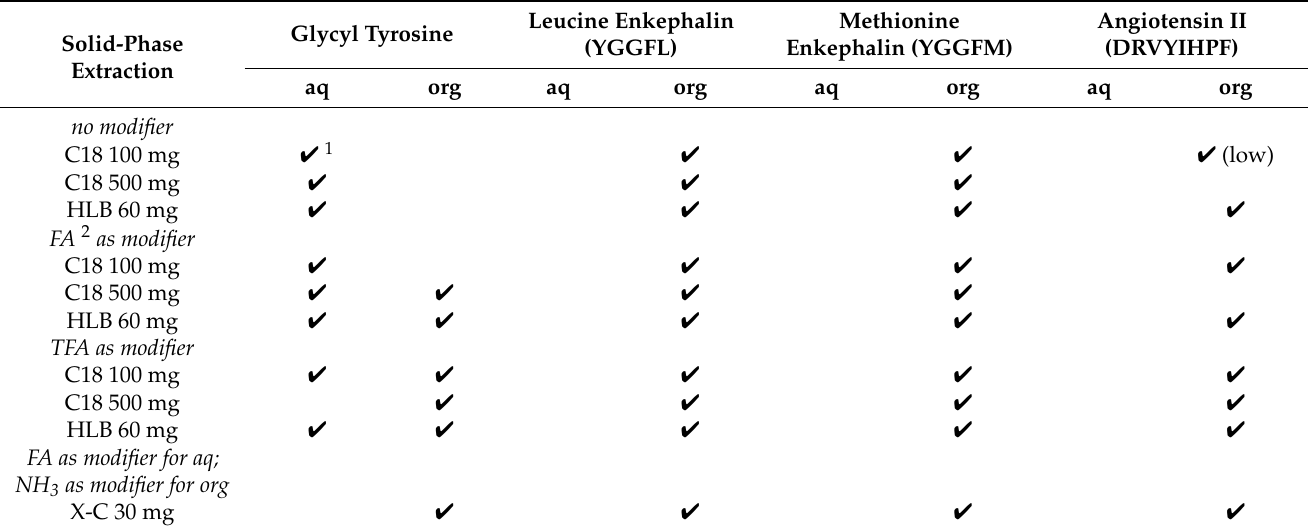
Table 1. Detection of peptide standards in aqueous (aq) and high-organic (org) fractions collected from different solid-phase extraction